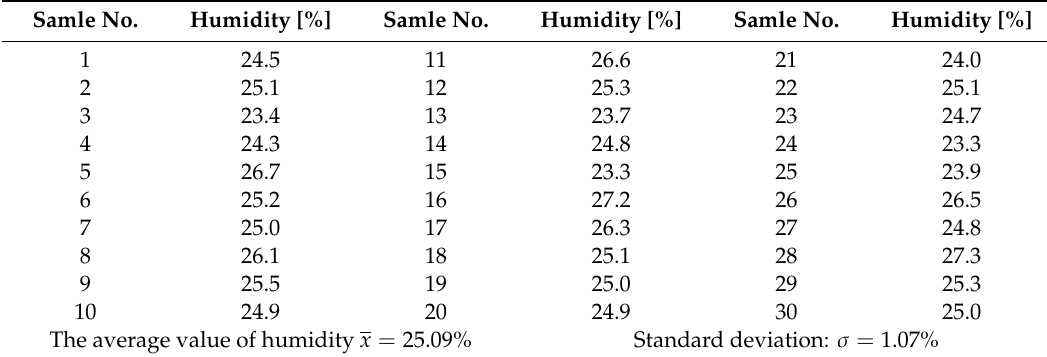
Table 3. The examined branches’ humidity measurement test results.